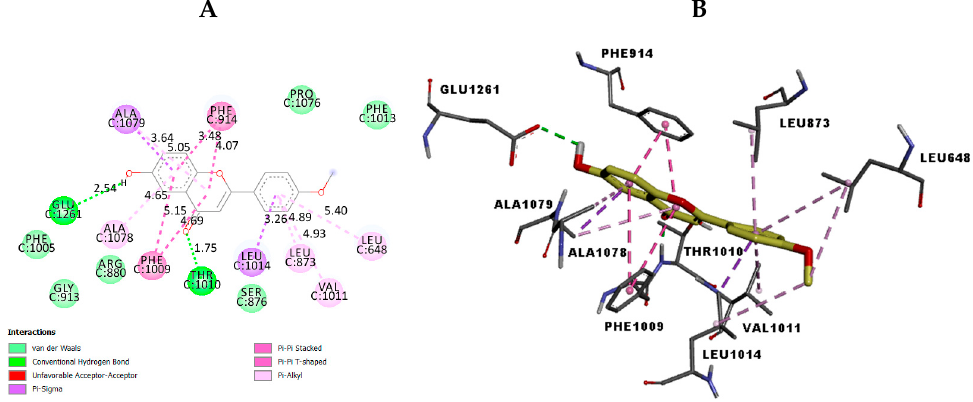
Figure 4. The 2D ( A ) view and 3D ( B ) view of the interaction type of M7 with the surrounding amino acids of superoxide dismutase.